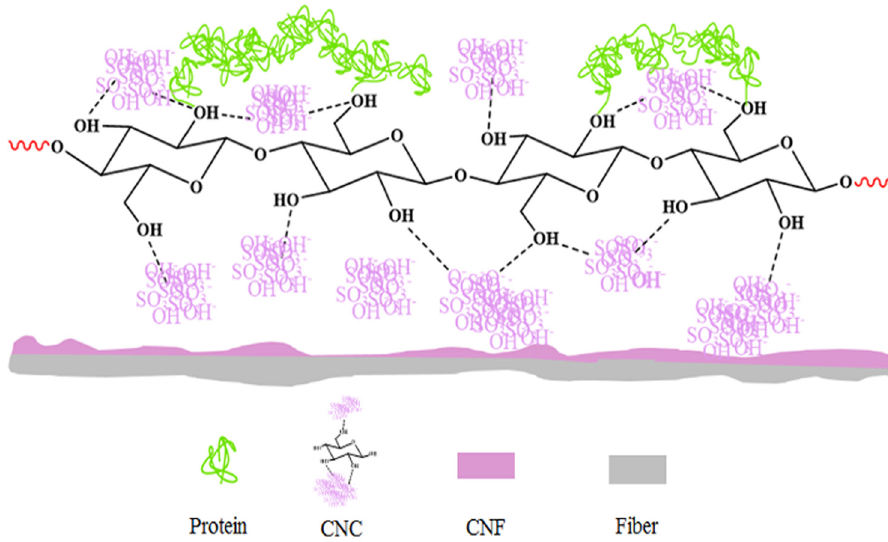
Figure 7: The enhanced adhesion of multilayered CNF and CNC